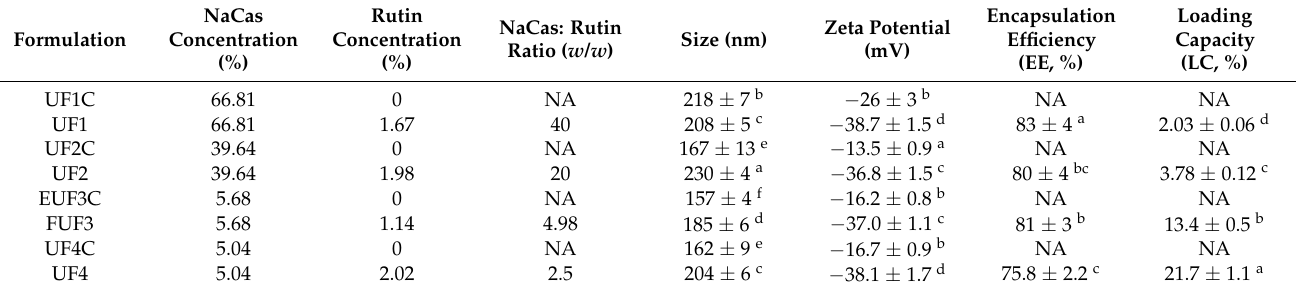
Table 2. The properties of the concentrated rutin-sodium caseinate (NaCas) nanoparticles (pH 7). NaCas Formulation